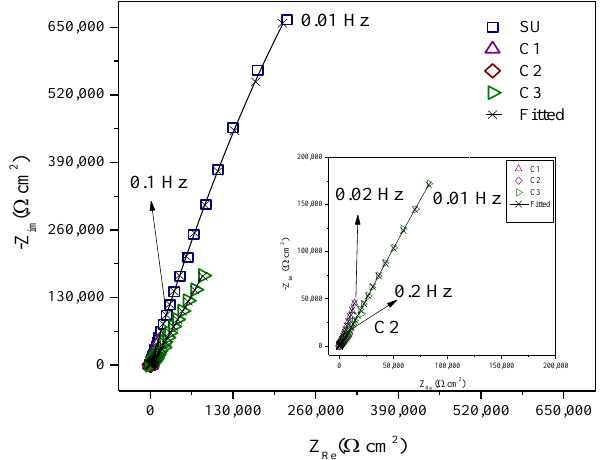
Figure 2. Nyquist diagram of substrate Inconel 718 and C1, C2 and C3 coatings exposed to 3.5 wt.% NaCl solution.